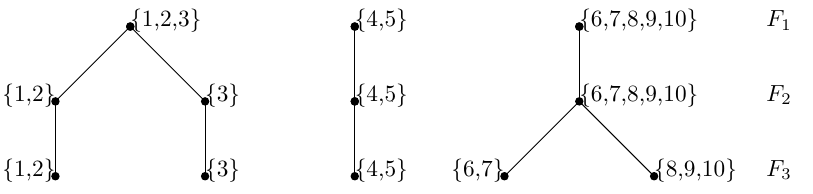
Figure 3. Cluster formation tree F